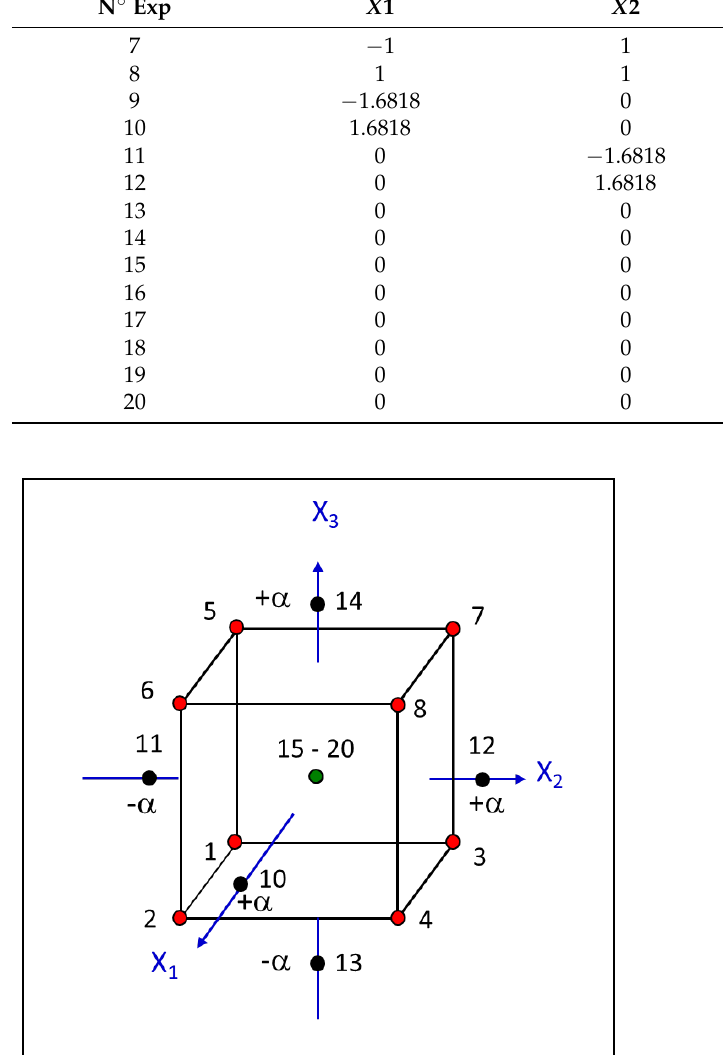
Figure 2. Geometry of central composite design with its three design factors.